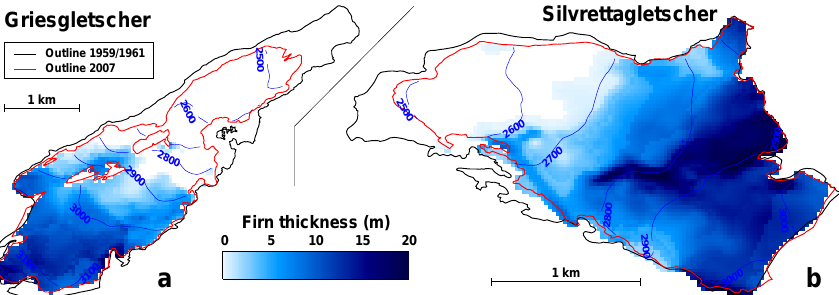
Fig. 1. Overview maps of (a) Griesgletscher and (b) Silvrettagletscher (enlarged by a factor 2), Swiss Alps, with glacier outlines around 1960 and in 2007, and modelled firn thickness (see below) in 1985 (down to pore close-off at 830kgm − 3 ). Table 1. Firn density data compiled from studies on temperate and polythermal glaciers in different mountain ranges. For each firn core the average density of the first 10m ρ 10 (in kgm − 3 ), the approximate mean accumulation rate b (m w.e. a − 1 ), and a qualitative statement about the thermal regime is given (temperate/polythermal). Some studies provide more than one firn core ( n c ), and values refer to an average. Reference Location n c ρ 10 b type Ambach and Eisner (1966) European Alps 1 700 1.2 temp. Oerter et al. (1982) European Alps 3 600 ≈ 1 temp. Sharp (1951) Western Canada 1 650 ≈ 1.5 temp. Zdanowicz et al. (2012) Arctic Canada 2 560 0.3–0.6 polyth. Kreutz et al. (2001) Tien Shan 1 650 1.3 polyth. Suslow and Krenke (1980) Pamir 1 620 ≈ 1 polyth. He et al. (2002) Himalaya 1 640 0.9 polyth. Matsuoka and Naruse (1999) Patagonia 620 temp. Shiraiwa et al. (2002) Patagonia P¨alli et al. (2002) Svalbard Nuth et al. (2010) Svalbard 510 ≈ 0.5